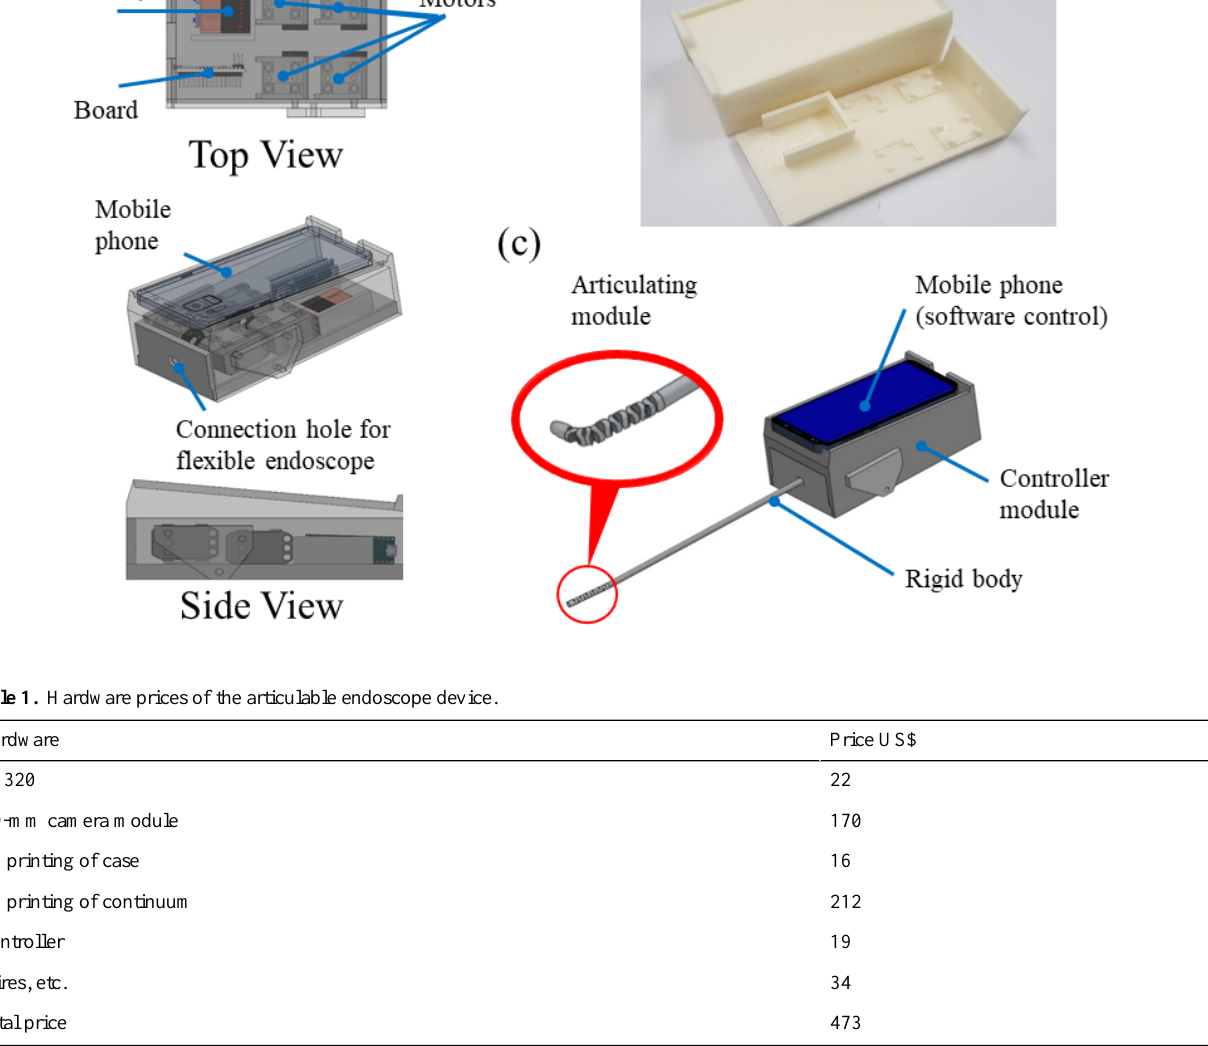
Figure 7 describes the general workflow algorithm of the